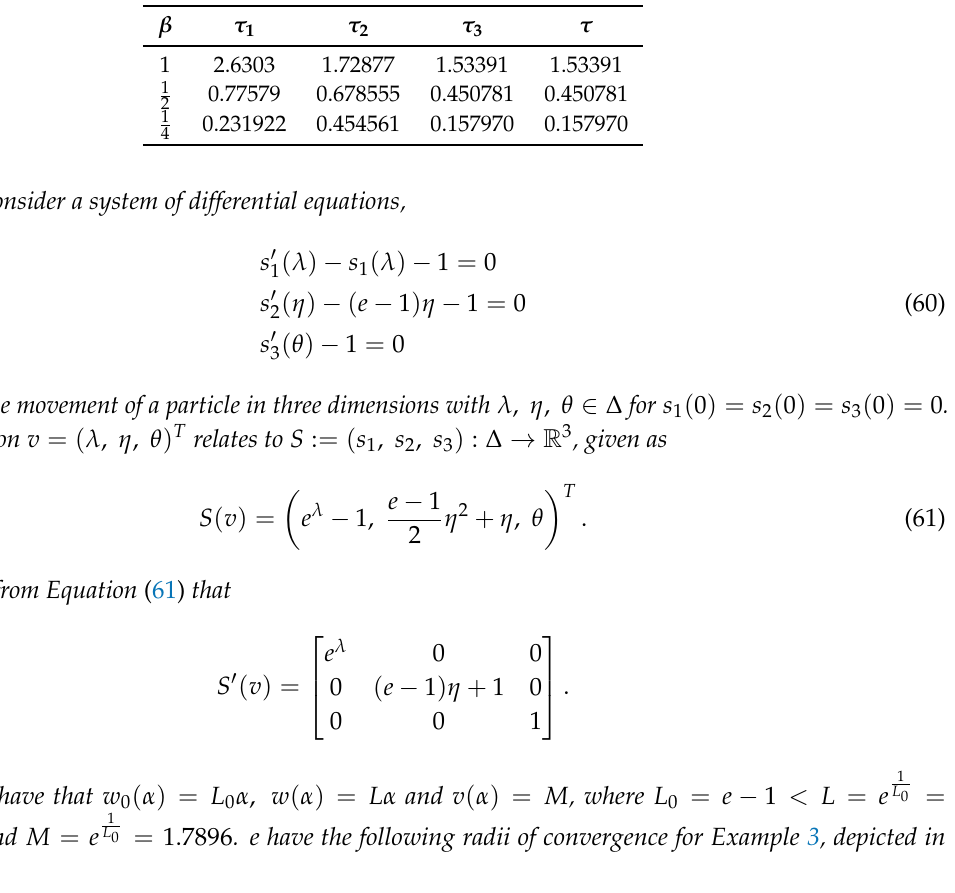
Table 3. Distinct convergence radii for Example 2.